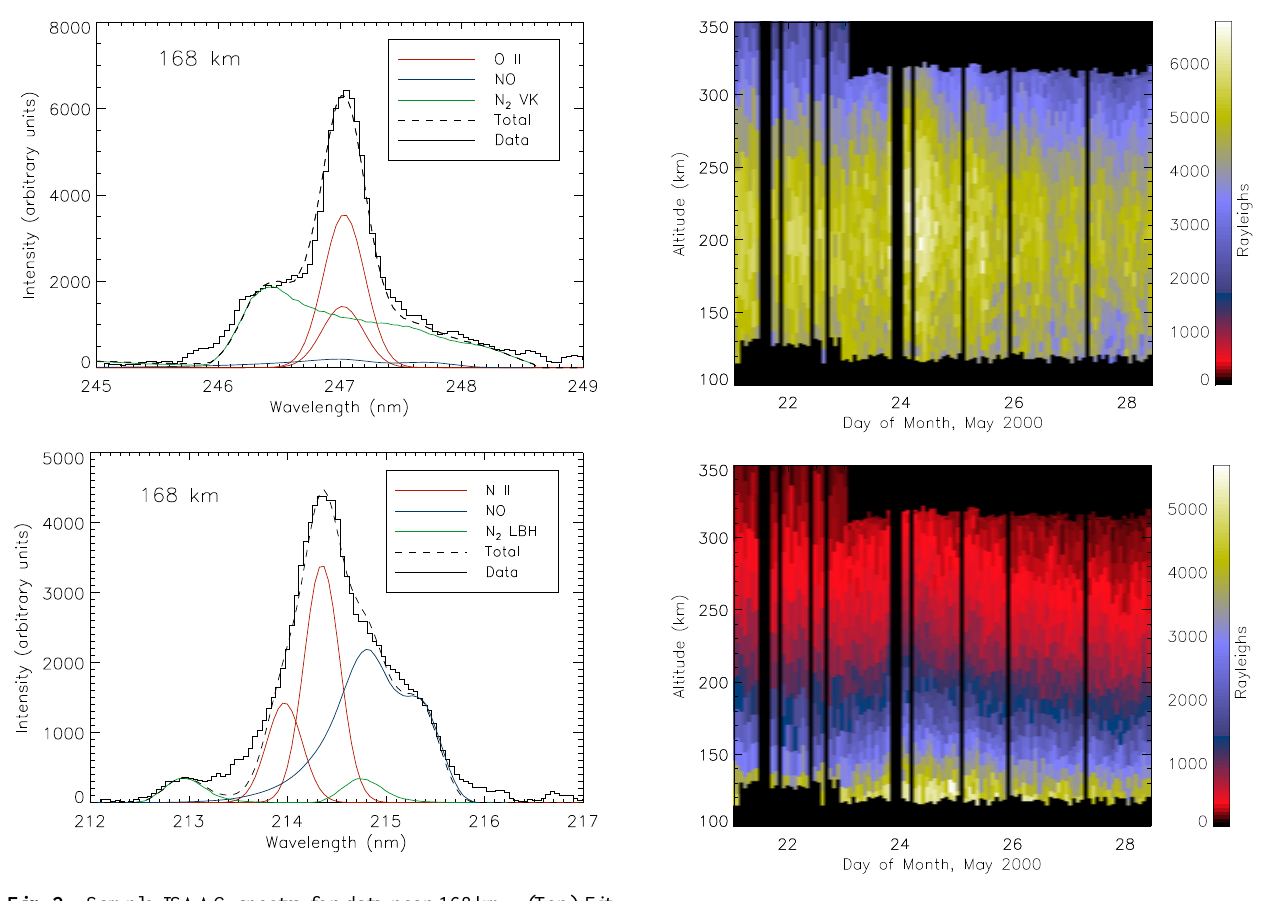
Fig. 3. Images of OII 247.0nm intensity (top) and NII 214.3nm intensity (bottom) from 21–28 May 2000. Each pixel represents an average of 10 spectra gathered with the tangent point of the line of sight located between 20 ◦ N and 20 ◦ S